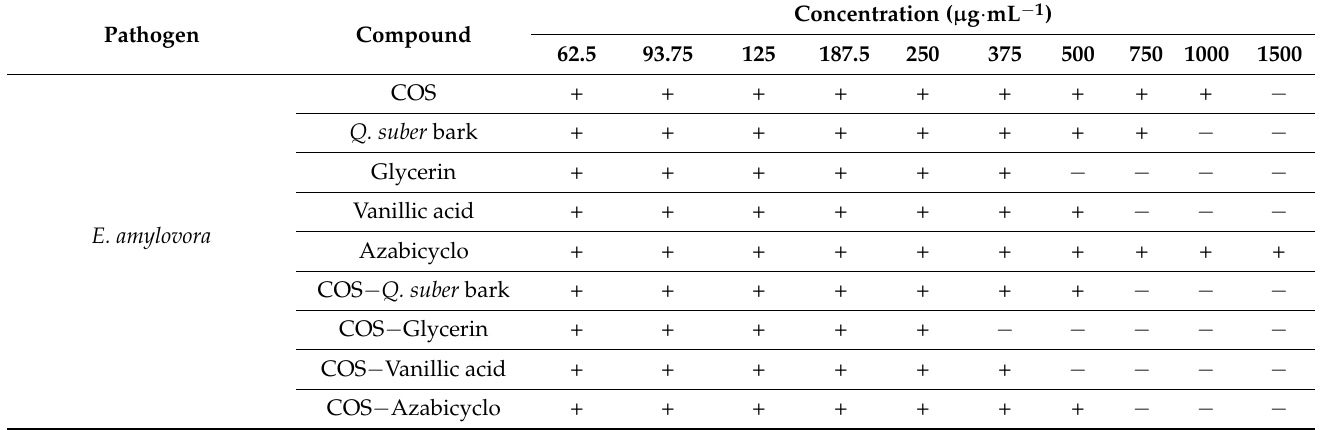
Table 4. Antibacterial activity against E. amylovora and P. syringae pv. syringae of chitosan oligomers (COS), the aqueous ammonia extract of Q. suber bark, and its main constituents, alone and upon conjugation with COS. Positive and negative signs indicate the presence/absence of bacterial growth.